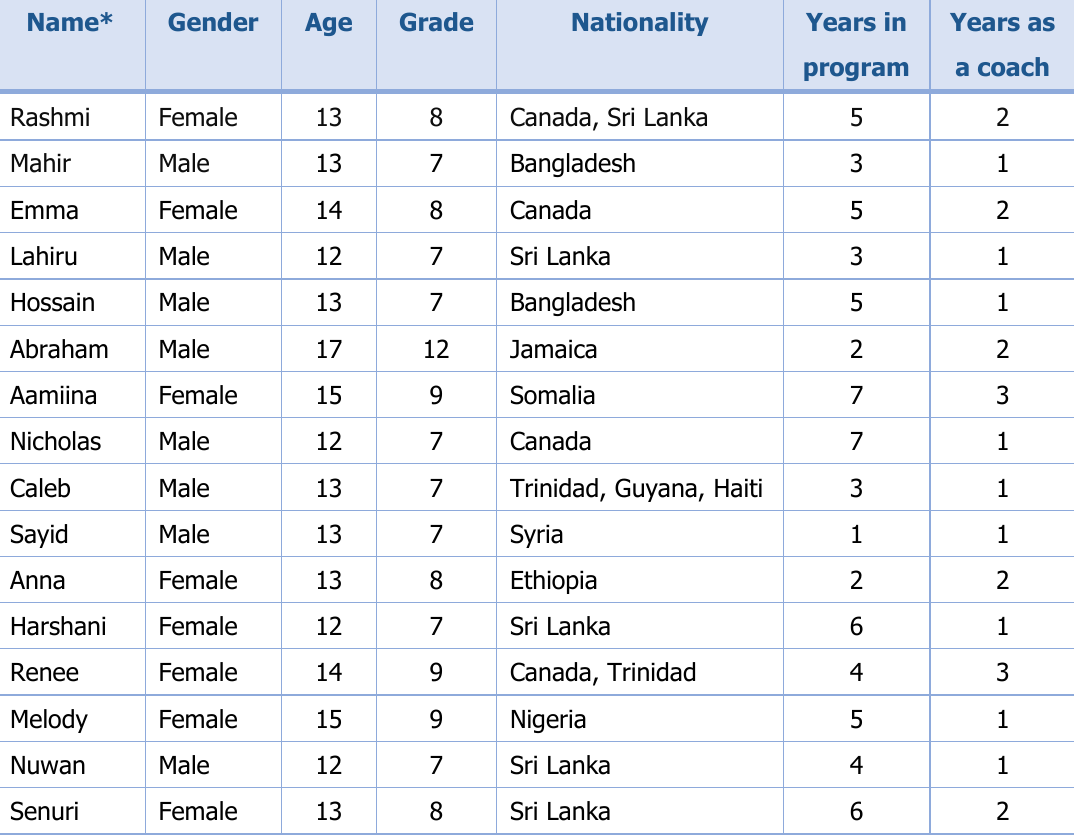
Table 1. Demographic Characteristics of the Junior